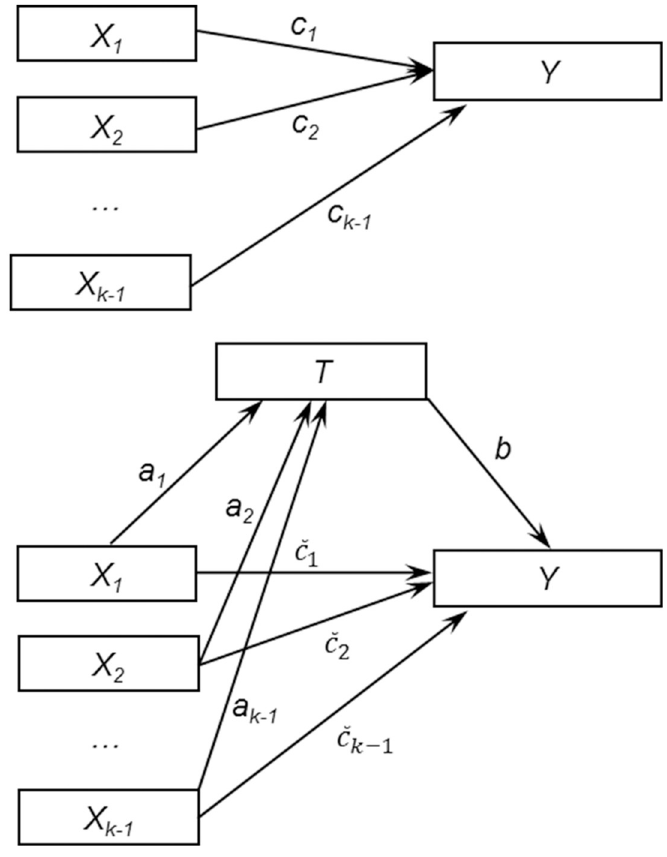
Fig 2. Mediation model with k-1 dummy variables created for the categorical exposure with k groups. Nodes represent the variables being analyzed in the mediation model, including the k -1 dummy-coded exposure variables, X 1 , X 2 , ... , X k − 1 , the mediator T and the outcome Y . A direct edge implies a potential direct causal effect. A pathway from one variable (e.g., X 1 ) to another ( Y ) implies a potential causal relationship through the mediator on the path ( T